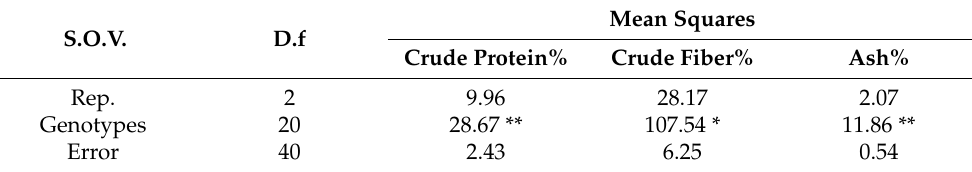
Table 6. Mean squares of quality traits of twenty-one genotypes of alfalfa in the first year.